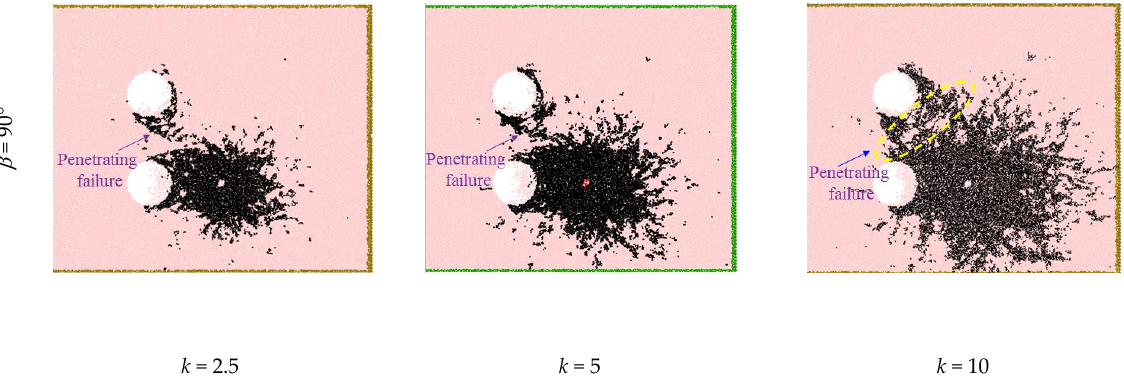
Figure 12. Microcrack distribution in surrounding rock under different wavelength.